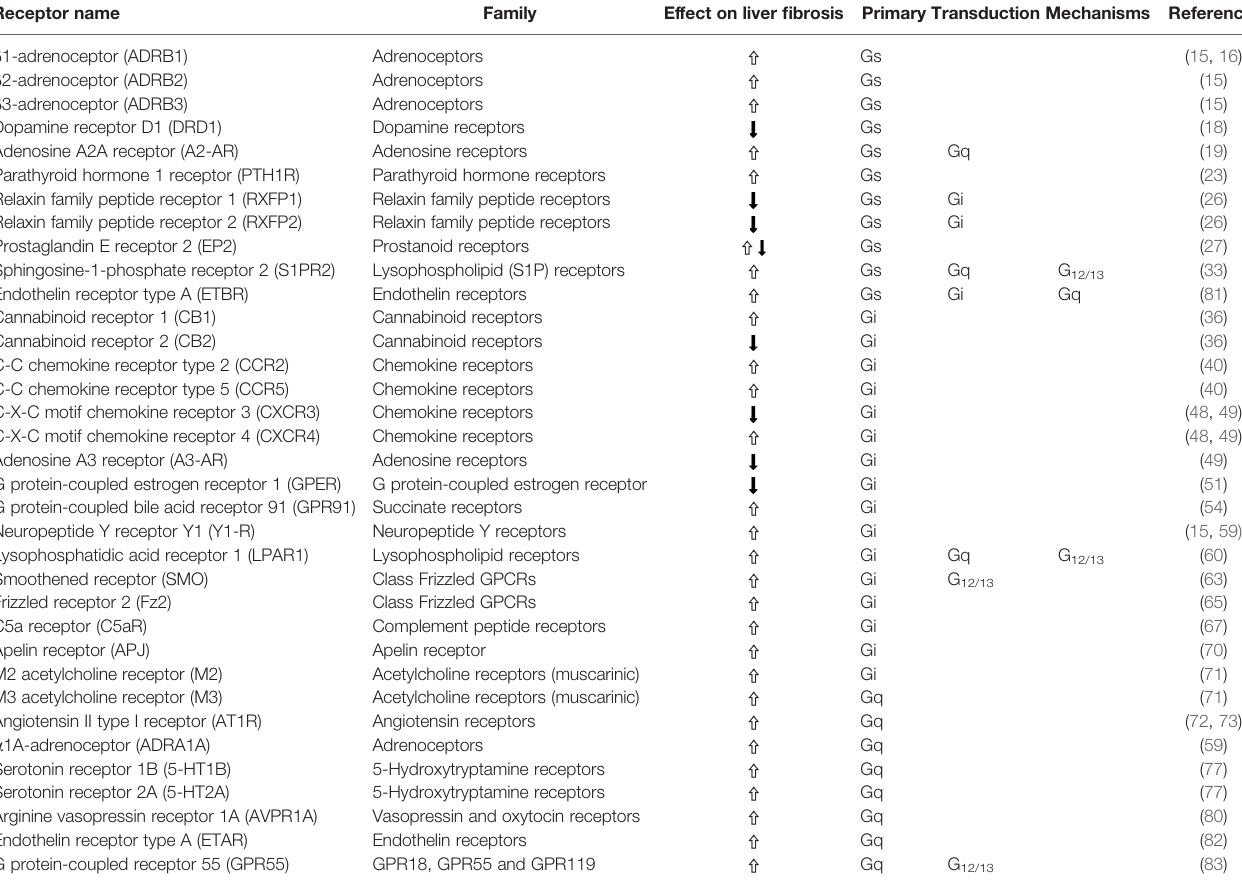
TABLE 1 | Fibrotic function of G protein-coupled receptors expressed in